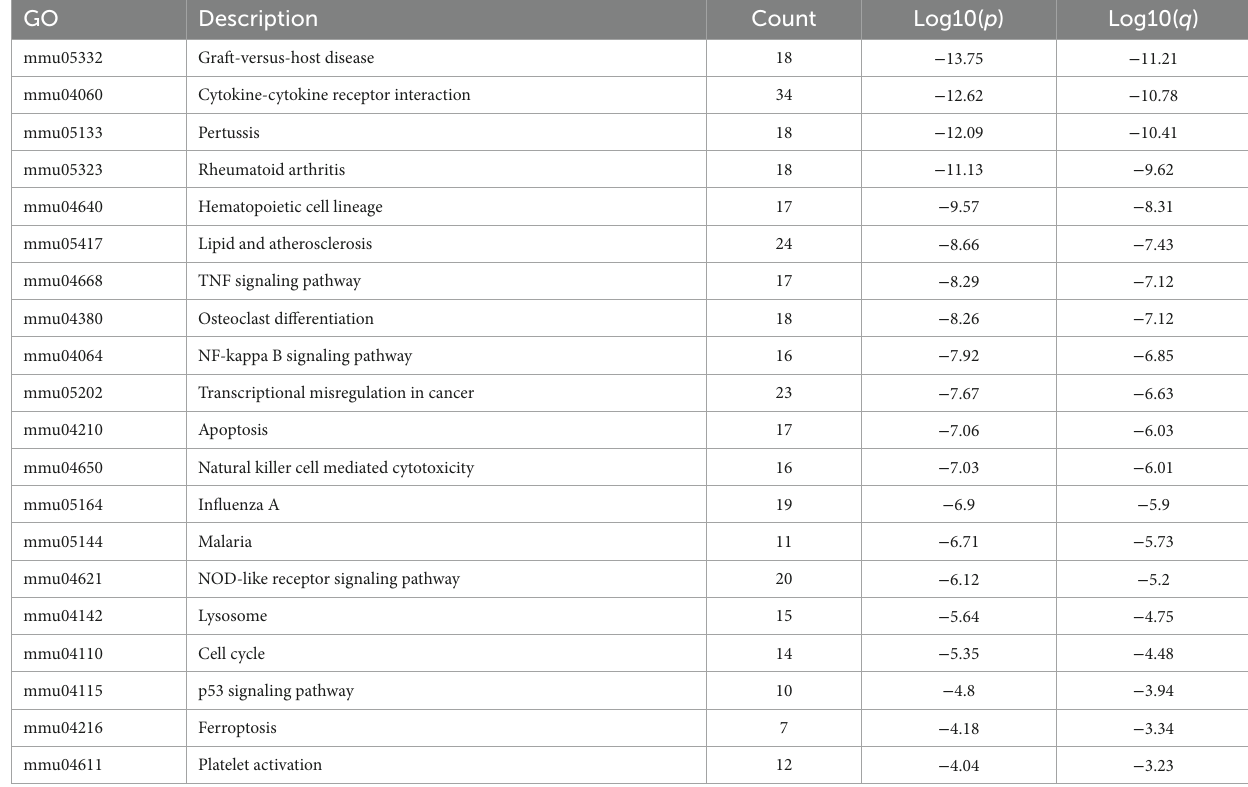
TABLE 5 Top 20 KEGG terms enriched by differentially expressed mRNA post-ICH.